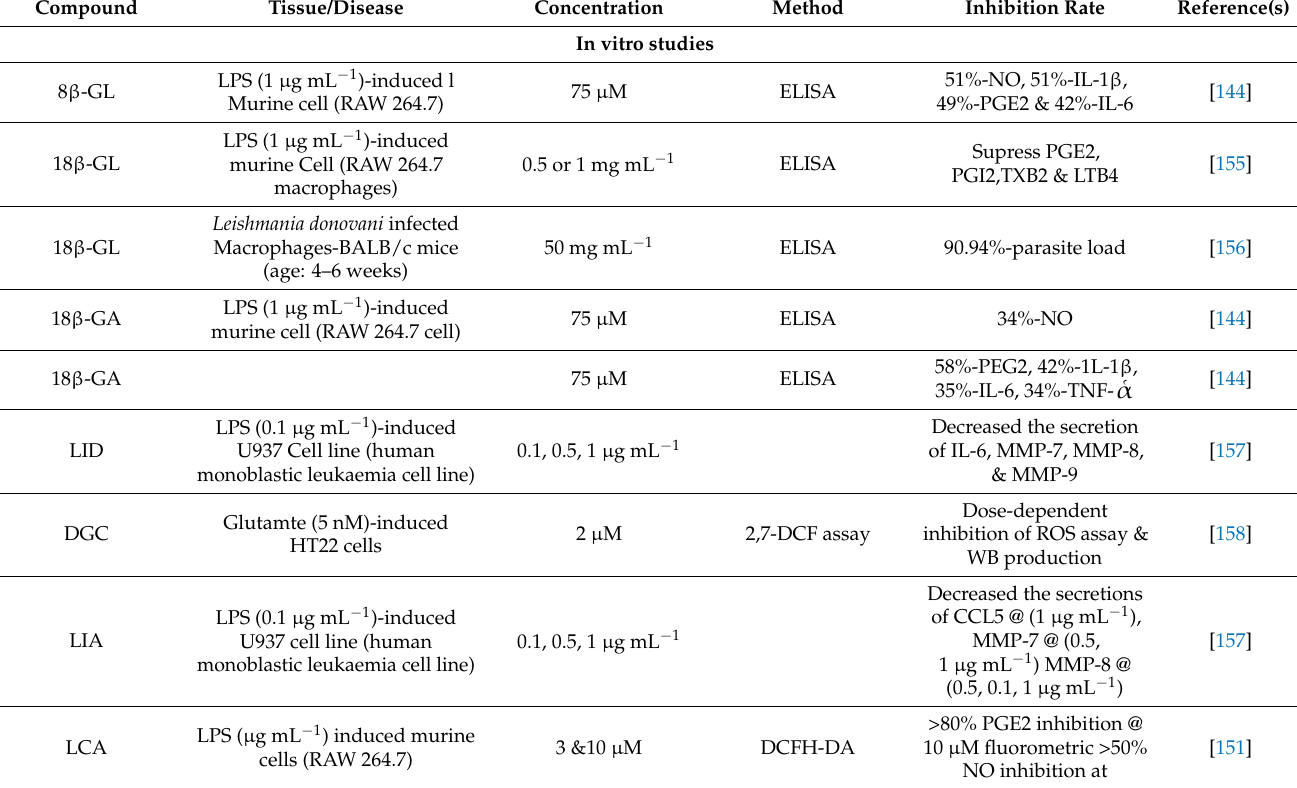
Table 3. The anti-inflammatory property of licorice extracts in various studies.